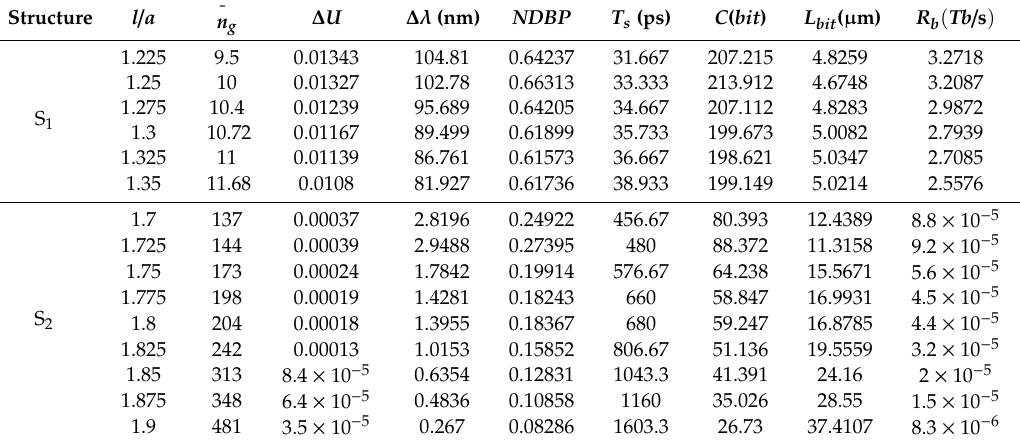
Table 1. Slow-light parameters and bu ff ering capability under di ff erent values of l for S 1 and S 2 .